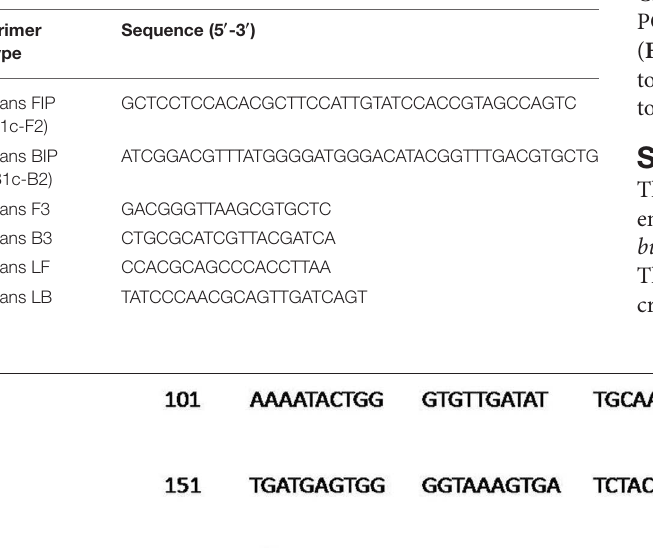
TABLE 1 | List of primer sequences for colorimetric loop-mediated isothermal amplification (LAMP).